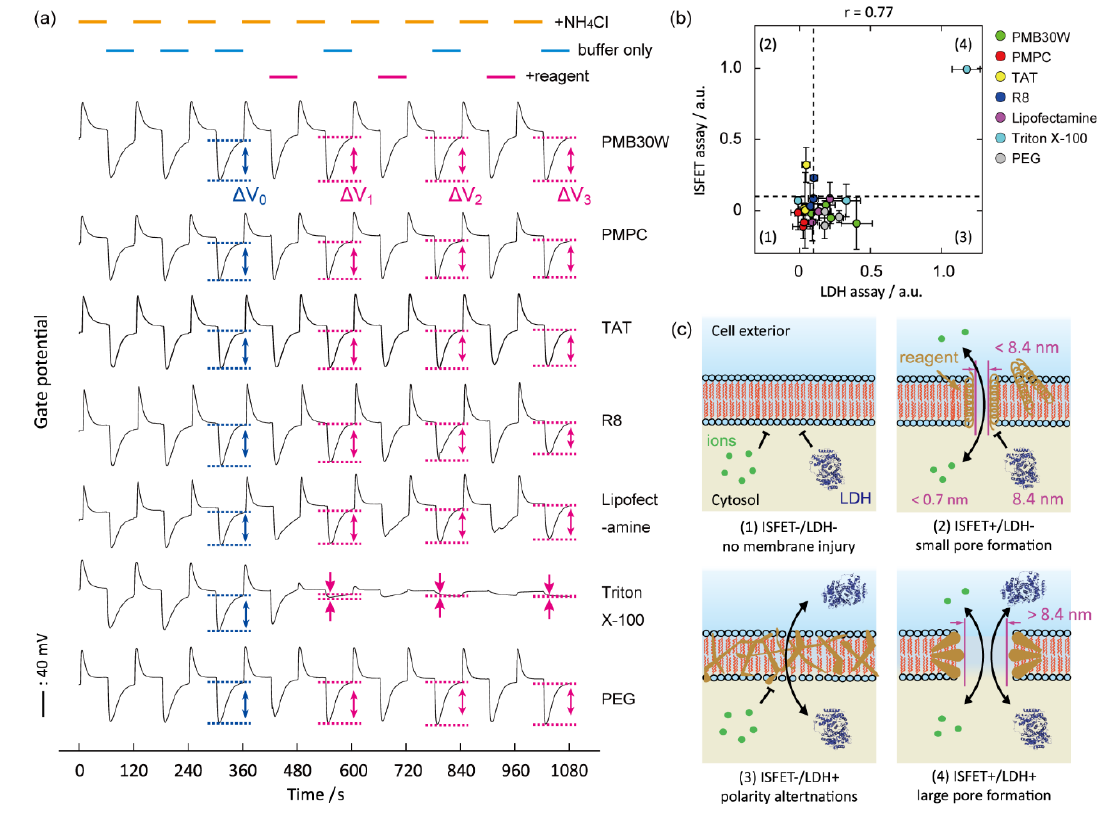
Figure 5. Cluster analysis between the ISFET and LDH assays for identifying the energy-independent permeation mechanism of PMB30W. ( a ) The pH perturbations during repeated exposures of a panel of reagents to cells using a superfusion system. ( b ) Scatter plot between the ISFET and LDH assays. Data points identify the two signals for the samples at set concentrations with mean ± SD ( n = 5). Dashed lines represent the thresholds defined at 0.1. ( c ) Schematic illustrations showing the types of biomembrane injuries based on the assignment of the four regimes in the correlation diagram. Reproduced with modification from [76] with permission by the American Chemical Society.